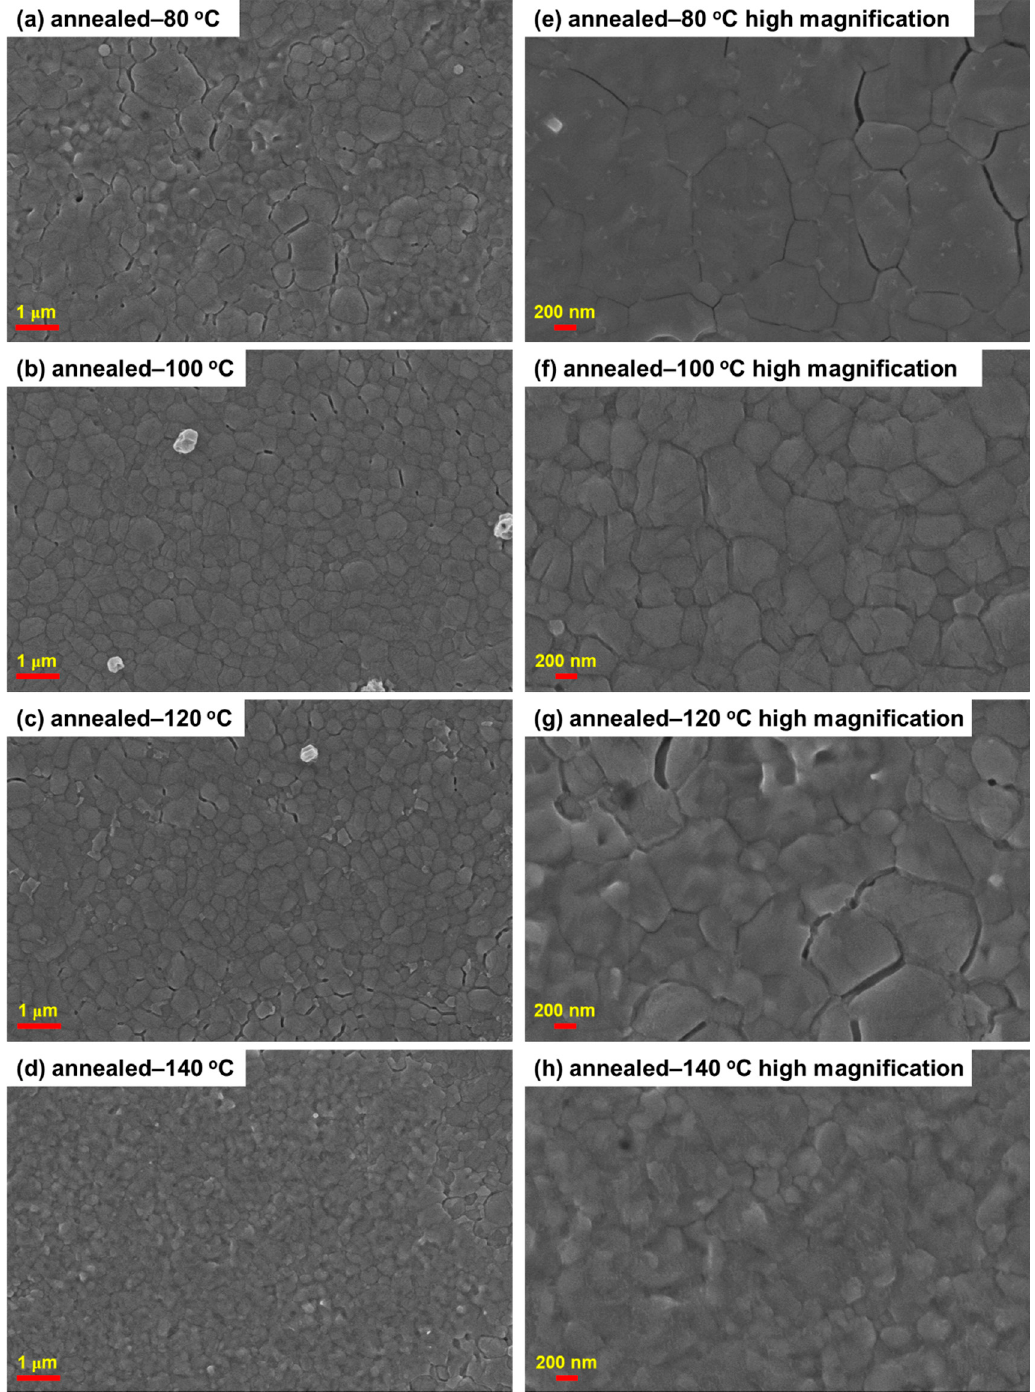
Figure 2. FE-SEM images of the top view of the MAPbI 3 /TiO 2 /FTO structure at different annealing temperatures, ( a , e ), ( b , f ), ( c , g ), ( d , h ), low and high magnifications annealed at 80, 100, 120, and 140 °C.